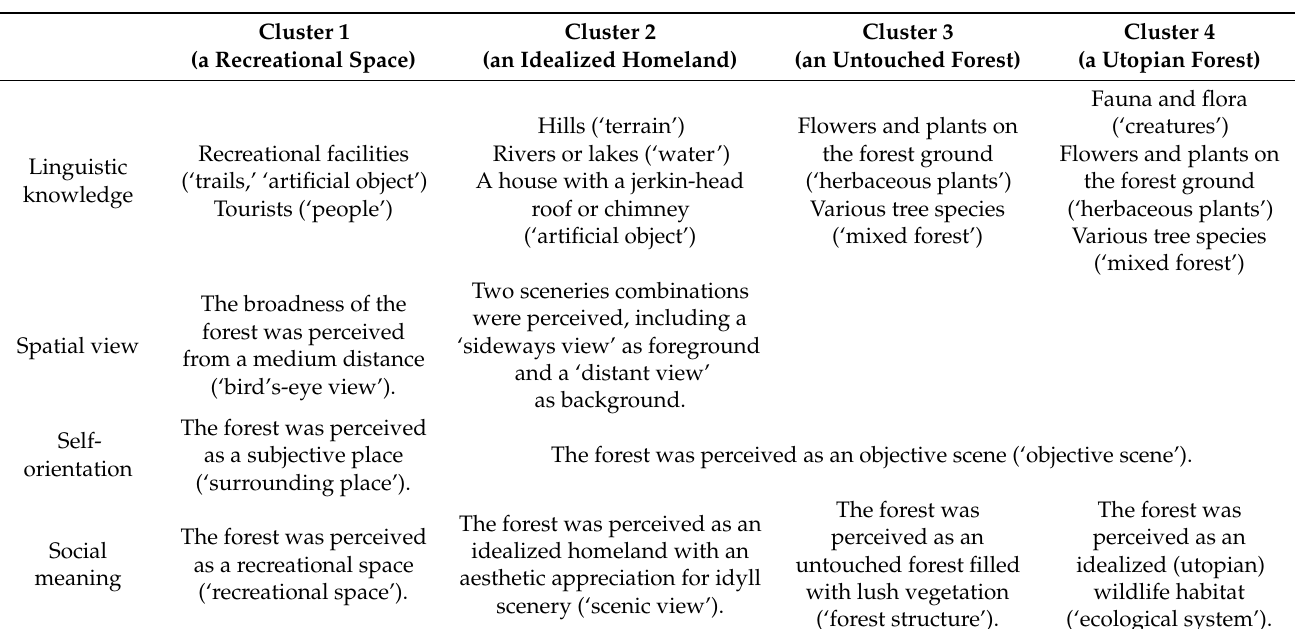
Table 4. The characters of four forest landscape